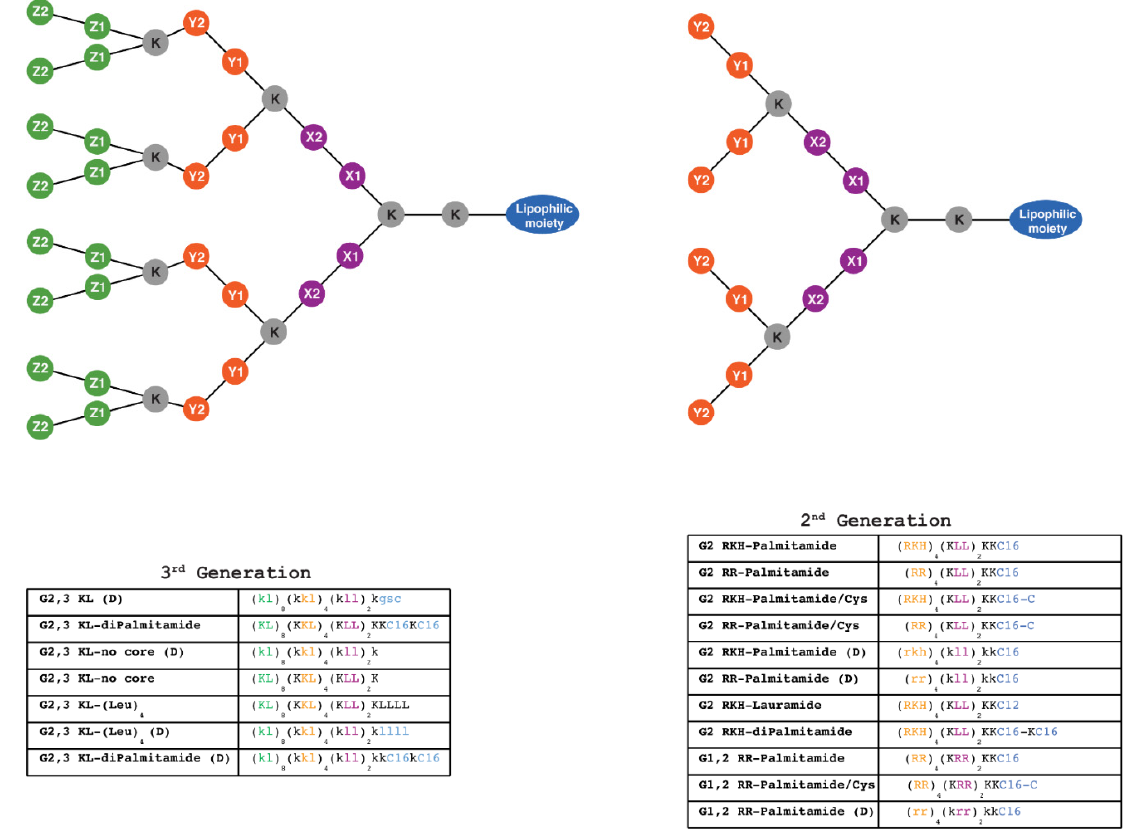
Figure 1. Schematic representation of 2nd and 3rd generation lipophilic peptide dendrimers synthesized using solid-phase chemistry. One-letter code is used to label amino acids forming the dendritic structure. The lipophilic moiety is composed of C12 (Dodecanoic acid), one or two C16 (Hexadecanoic acid), with or without C (Cysteine), or composed of four L (Leucine). K (Lysine) is the branching point for building higher generations, as well as constituting part of the structure and the cationic charge along with, R (Arginine), H (Histidine), and L (Leucine) which are the building units that constitute the rest of the structure. X1, X2, Y1, Y2, Z1, Z2 represent the position of the amino acid with the matching color code (X1 and X2: amino acids in the first layer; Y1 and Y2: amino acids in the second layer; Z1 and Z2: amino acids in the third layer). Capital and small letters indicate L and D stereochemistry of the amino acids, respectively. All dendrimers contain 2 amino acids in the outer layer, except (G2 RKH-Palmitamide, G2 RKH-Palmitamide/Cys, G2 RKH-Palmitamide (D), G2 RKH-Lauramide, and G2 RKH-diPalmitamide) that contain three amino acids. Dendrimers: G 2,3 KL-diPalmitamide, G 2,3 KL-diPalmitamide (D), G 2,3 KL-(Leu) 4 , and G 2,3 KL-(Leu) 4 (D) were denoted as MH13, DMH13, MH18 and DMH18, respectively, in a previous publication [34].